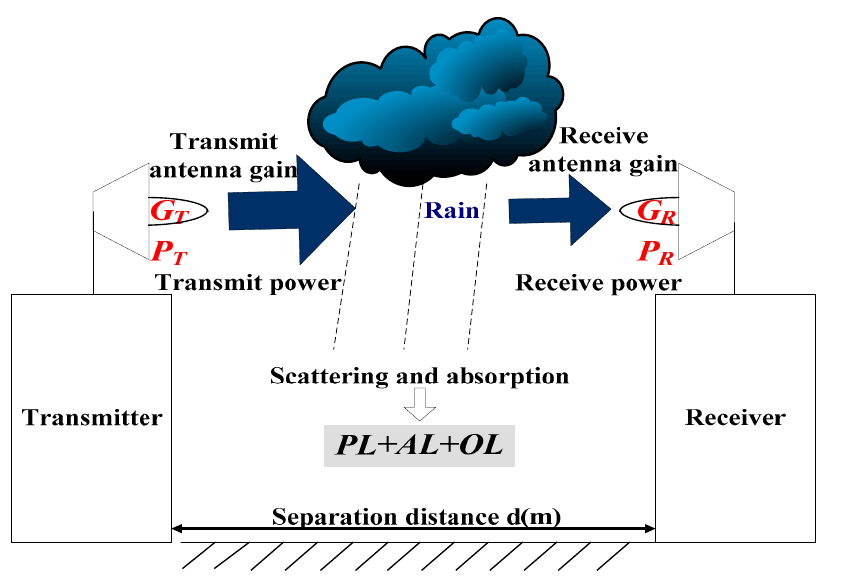
Figure 2. E-band millimeter-wave signal transmission schematic diagram. The received power